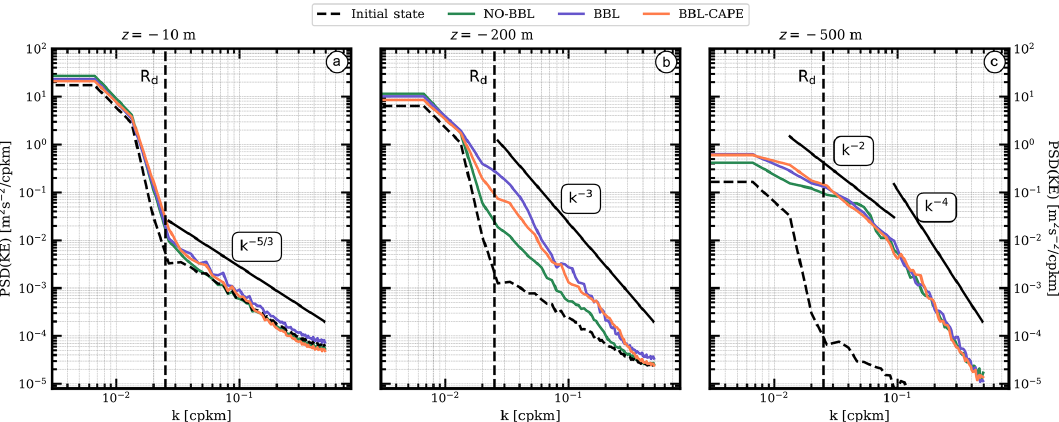
Figure 4. Kinetic energy (KE) spectra comparison of the three experiments: NO-BBL (green), BBL (blue) and BBL-CAPE (orange). Spectra are computed at (a) 10, (b) 200 and (c) 500m depth at day 200. Black lines stand for benchmarks of power